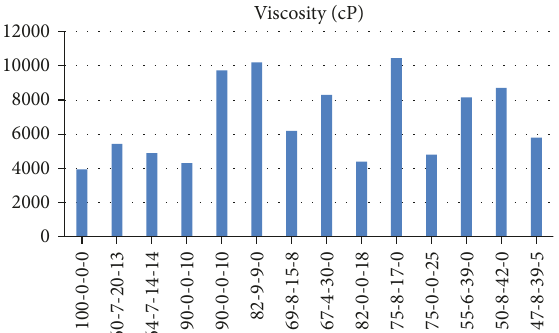
Figure 3: The viscosity values for the composites. The solution made from the solvent mixture 75-8-17-0 is the most viscous solution due to the intermolecular interactions between the ingredients of the solvent mixture and the